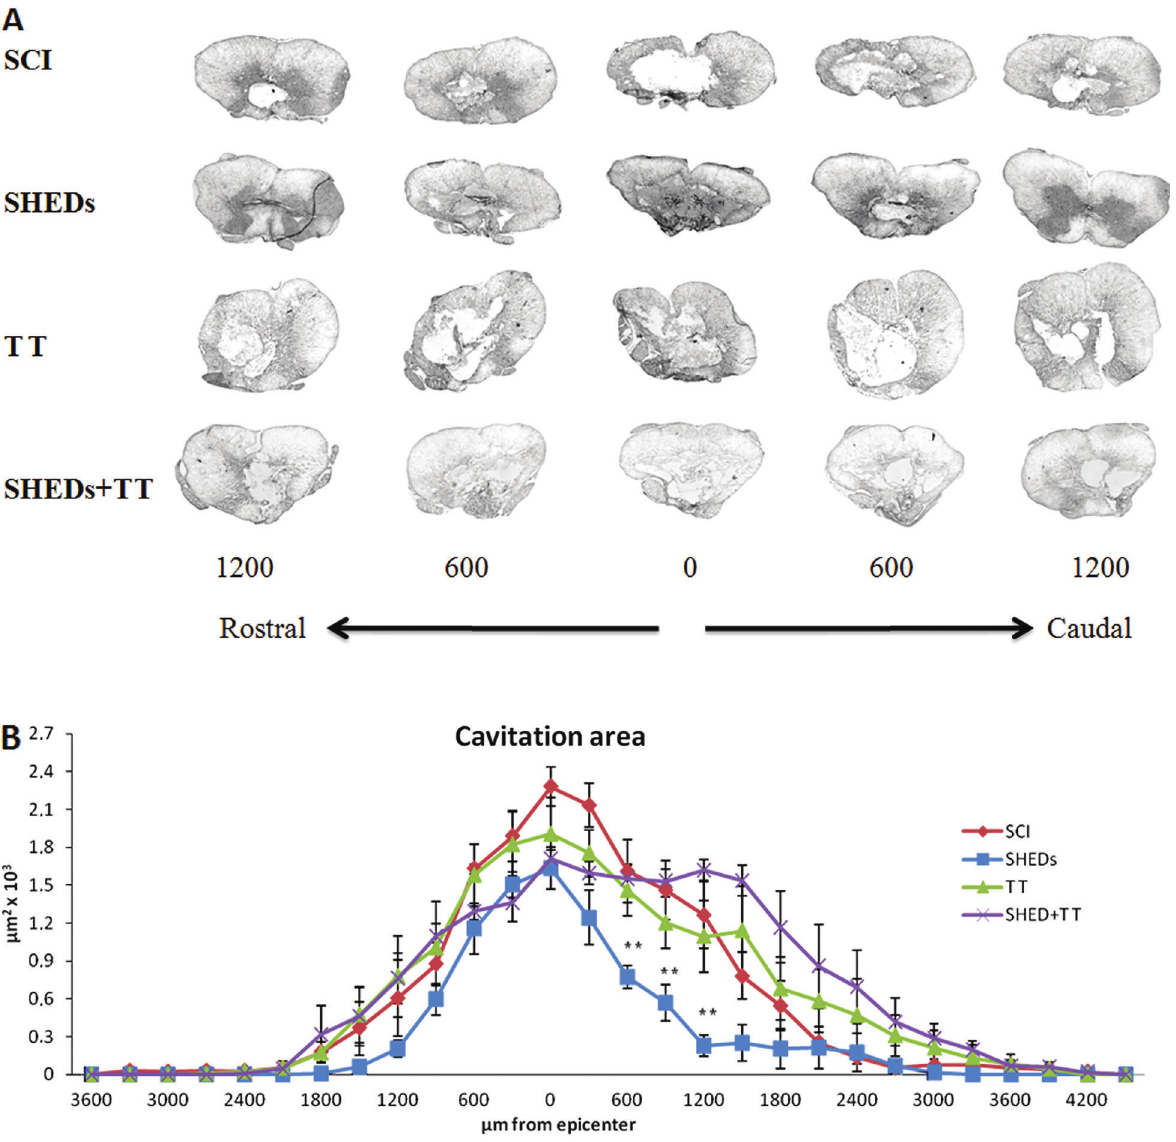
Figure 4. Representative images of cavitation areas ( A ) and cavitation area analysis ( B ) of incomplete spinal cord injury (SCI), SCI treated with stem cells from human exfoliated deciduous teeth (SHEDs), SCI treated with treadmill training (TT), and SCI treated with SHEDs and treadmill training (SHEDs + TT) rats. Data are reported as means ± SE. **P o 0.05, SHEDs group compared to SCI group (one-way ANOVA followed by Tukey ’ s post hoc